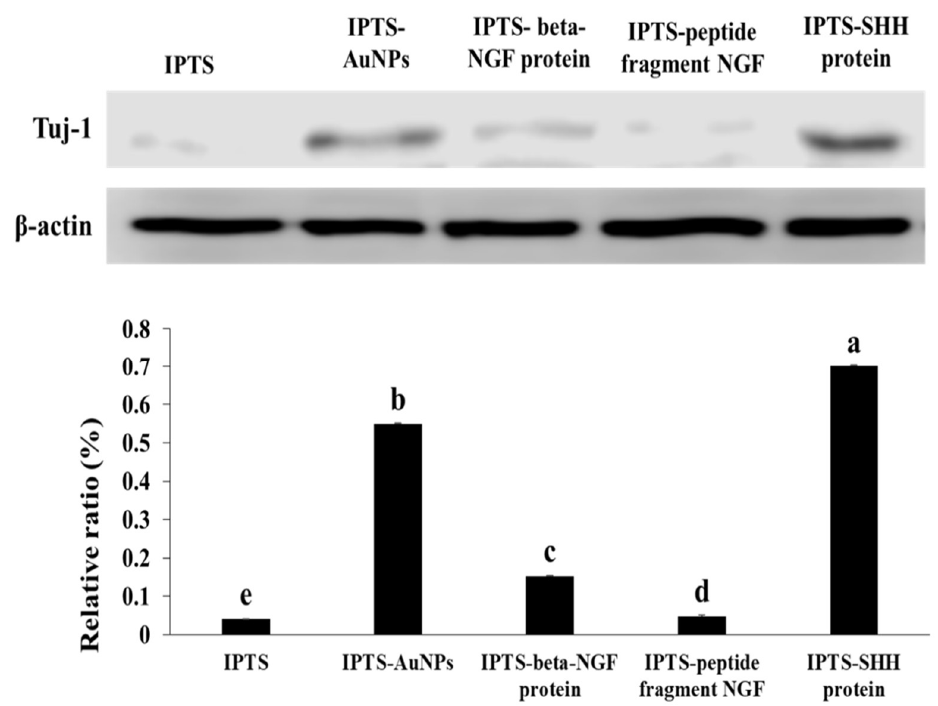
Figure 6. Levels of TUJ-1 protein determined by Western blot. The relative expression level was quantified using ImageJ and normalized to β-actin. Data are presented as the mean ± standard deviation. The bars not sharing a common lowercase letter (a–e) are significantly different according to Duncan’s multiple range test ( p < 0.05).